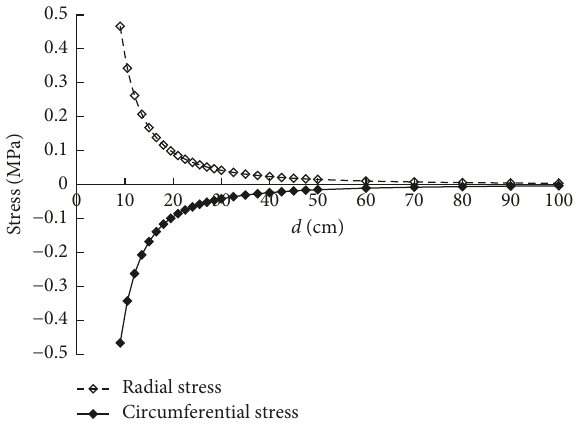
Figure 2: Calculation results of surface stress of the CC pavement structure model.